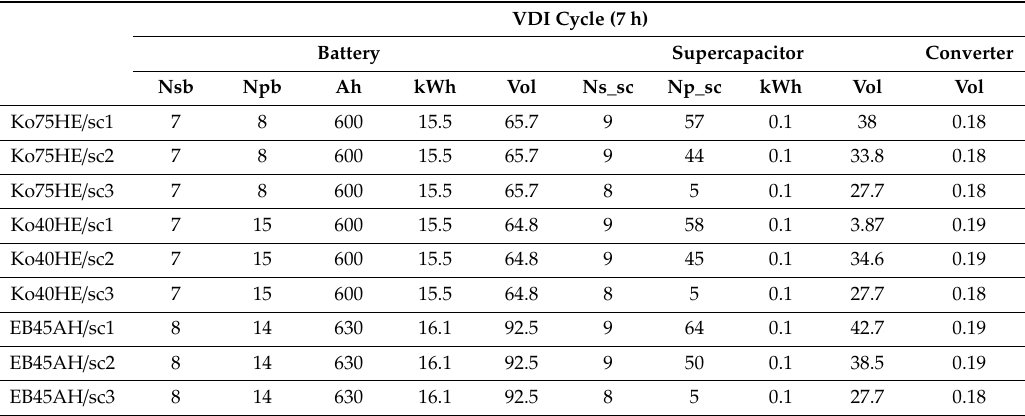
Figure 8. Weight results for the hybrid sizing (7 h VDI cycle range). Table 4. Results from hybridization (number of cells, capacity and volume).